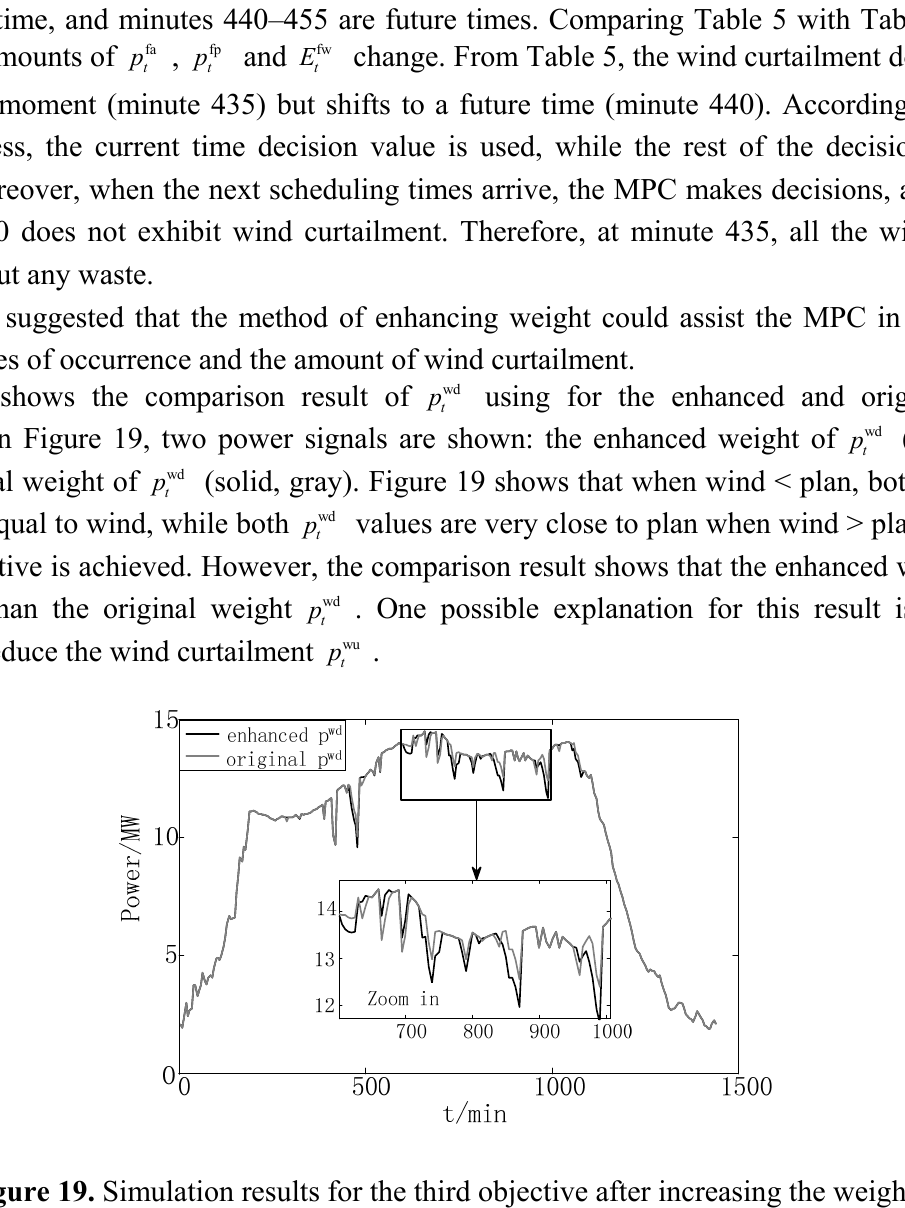
Figure 19. Simulation results for the third objective after increasing the